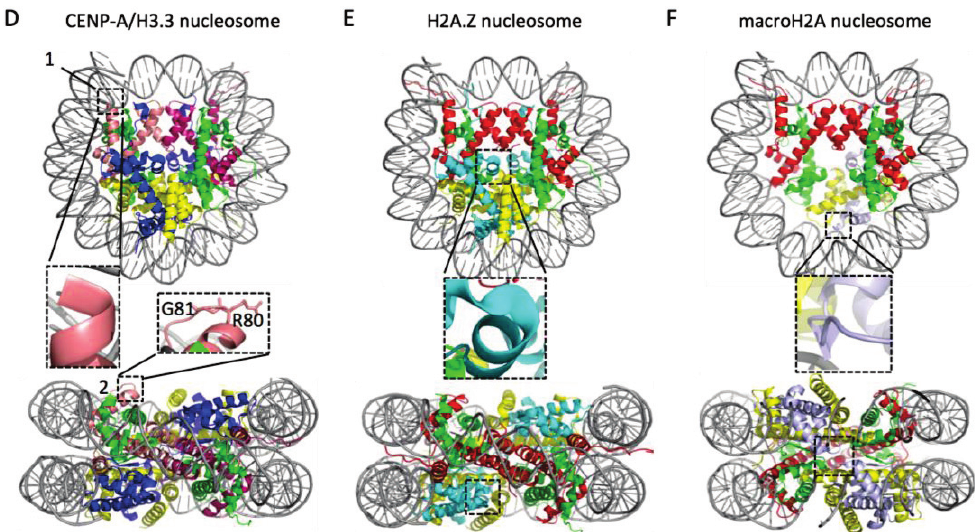
Figure 2. Crystal structures of nucleosomes containing histone variants. In each panel the nucleosome is shown in top and side view. In general, the colors used are red for H3, green for H4, blue for H2A, yellow for H2B, and grey for DNA. For the nucleosomes with histone variants ( B – F ) boxed areas and corresponding insets magnify specific